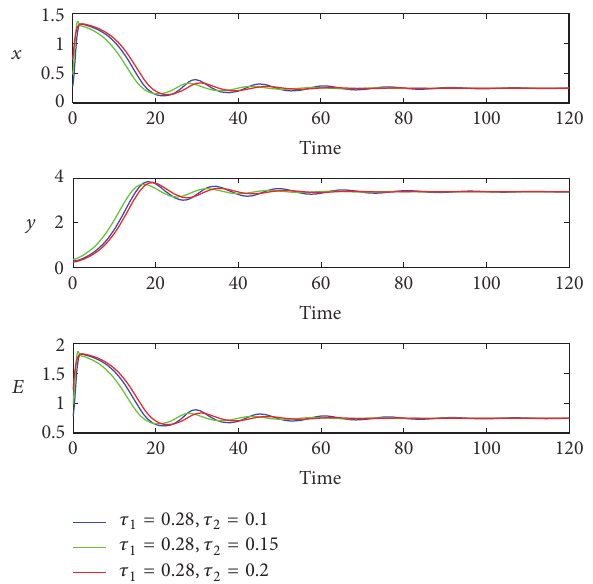
Figure 2: Stable dynamical variation of optimal prey, predator biomass and optimal harvest control with the increasing time under = 0.28 and 𝜏 = 0.1, 0.15, 0.2 , 𝜏 1 2